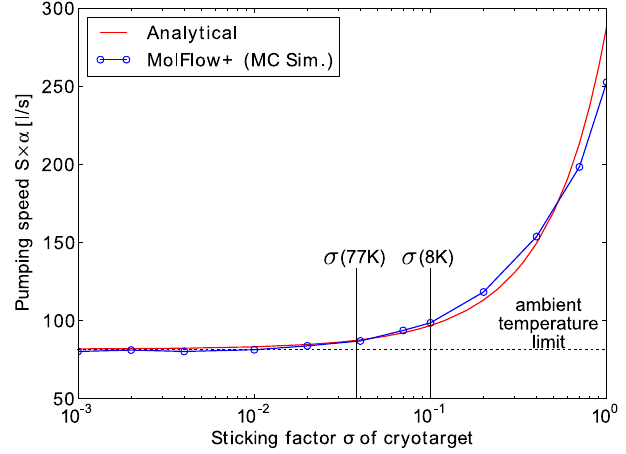
FIG. 4. Product of pumping speed S and reduction factor (cid:5) as a function of sticking probability (cid:4) for the used experimental setup calculated; the shown curves were calculated for